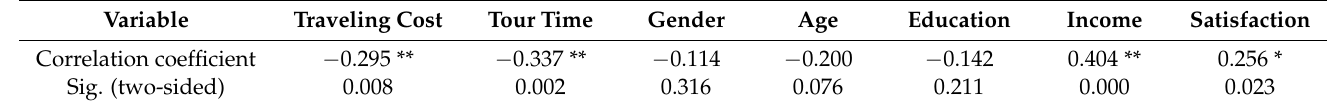
Table 6. Analysis of the correlation between the number of trips to Guanglu Island and other factors.